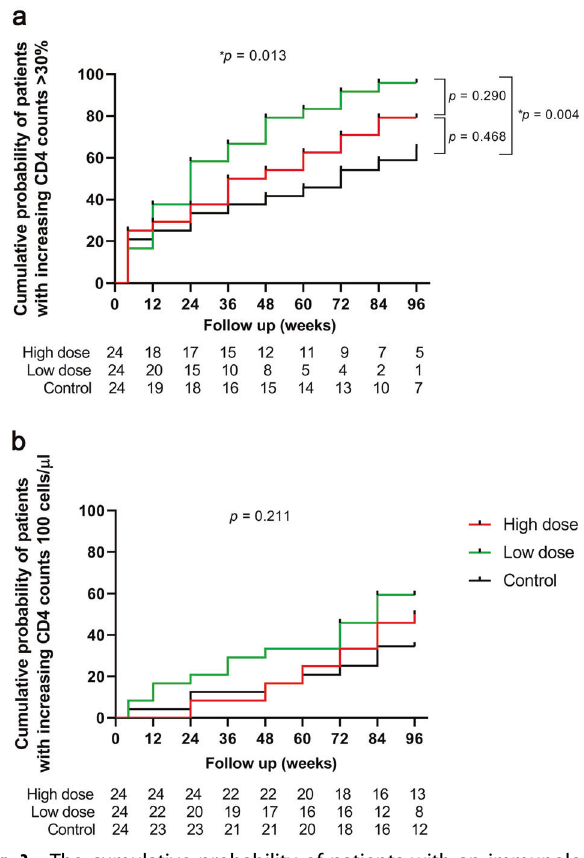
Fig. 3 The cumulative probability of patients with an immunologi- cal response. Analyses of the cumulative probability of patients whose CD4 counts increased > 30% ( a ) or ( b ) >100 cells/ μ L compared with baseline